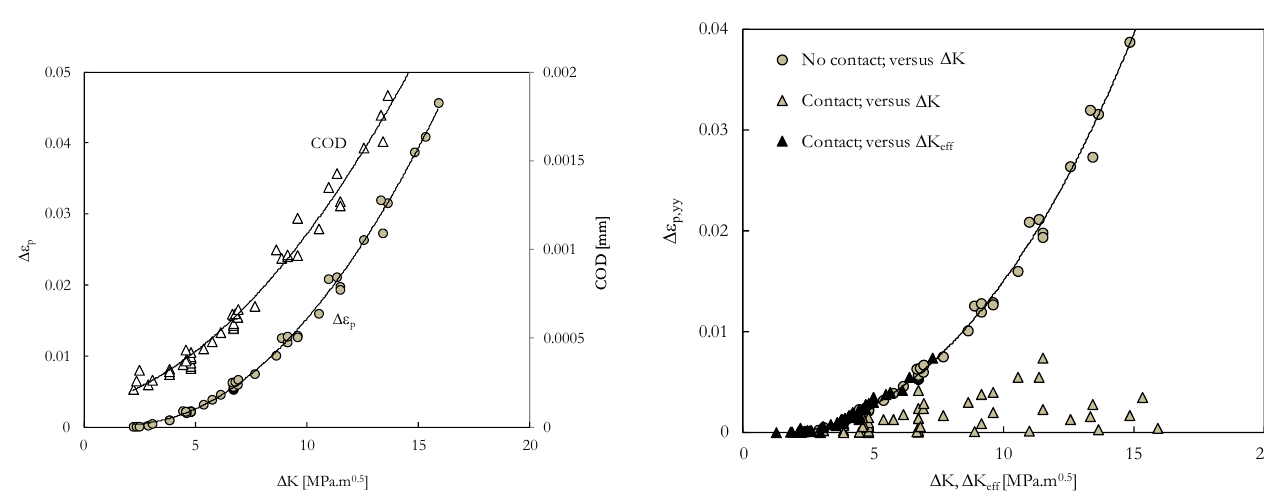
Figure 3: Effect of effective stress intensity factor range,  K eff , on plastic strain range.